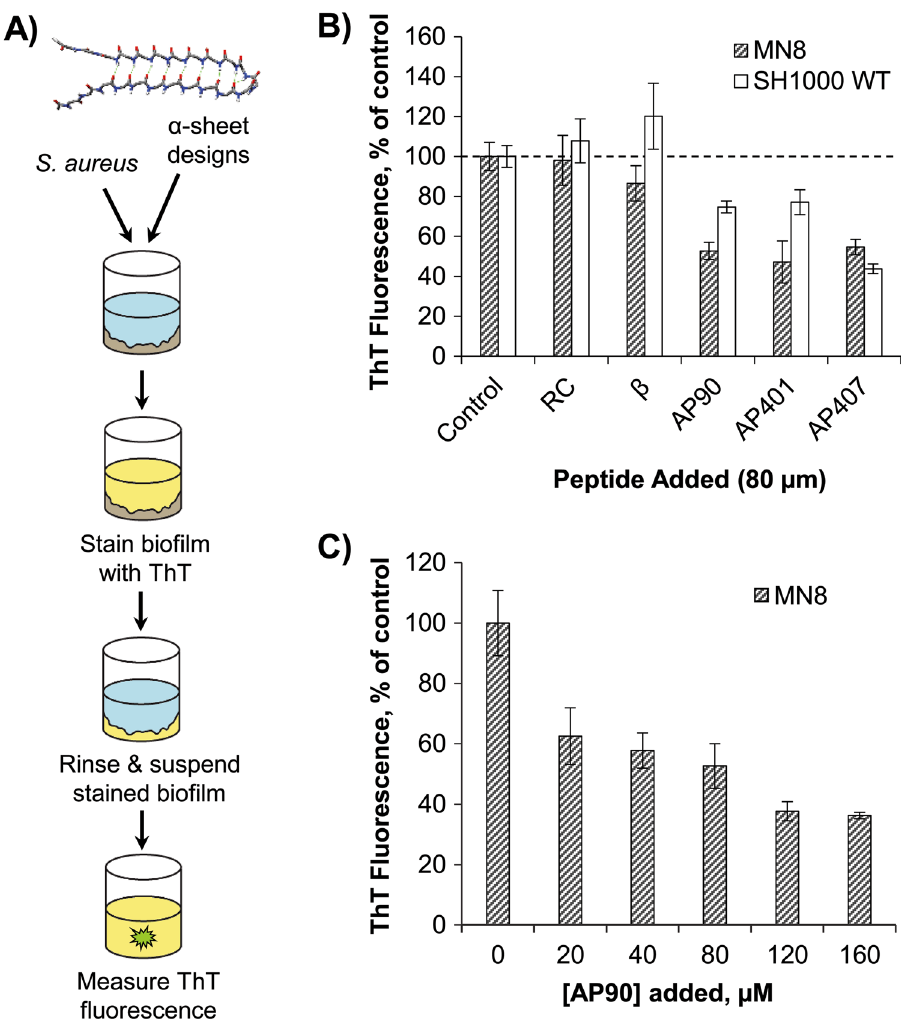
Fig. 1 Screening of designed peptides for inhibition of amyloid formation in S. aureus bio fi lms. a Schematic of protocol for testing designed α -sheet peptides in S. aureus bio fi lm cultures with an illustration of the main-chain structure of the AP90 α -sheet design. b A panel of designed α -sheet peptides (AP90, AP401, and AP407), as well as random coil (RC) and β -hairpin controls ( β ), was tested against two S. aureus strains, MN8 ( hashed bars ) and SH1000 WT ( white bars ). ThT fl uorescence fl uorescence values indicate the extent of amyloid formation in the EM and are shown as the percent of peptide-free control conditions. c Dose-response curve for the designed peptide AP90 against S. aureus MN8 bio fi lms reveals a signi fi cant decrease in EM amyloid content as the concentration of AP90 is increased. Error bars in b and c represent the standard error of the mean for experiments performed in